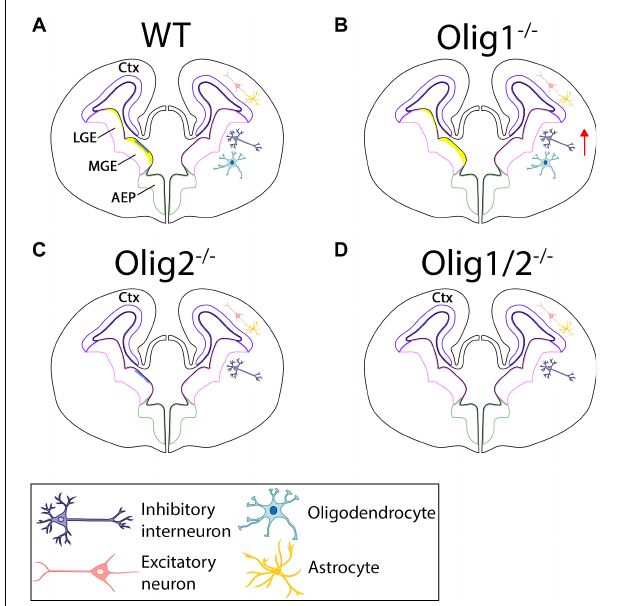
FIGURE 2 | Schematic of cellular patterning in the mammalian forebrain after loss of Olig function. (A) In the WT forebrain, Olig1 and Olig2 are expressed in the LGE and MGE. Olig2 (yellow) is highly upregulated along the borders of the MGE with little expression in the LGE. Olig1 (blue) is slightly expressed in the MGE. Astrocytes and excitatory neurons are generated in the ctx while interneurons and oligodendrocytes are formed from the LGE and MGE. (B) Loss of Olig1 results in an increase in interneurons. (C) Loss of Olig2 results in loss of oligodendrocytes. (D) Loss of Olig1 and Olig2 results in only loss of oligodendrocytes. Ctx = cortex, LGE = lateral ganglionic eminences, MGE = medial ganglionic